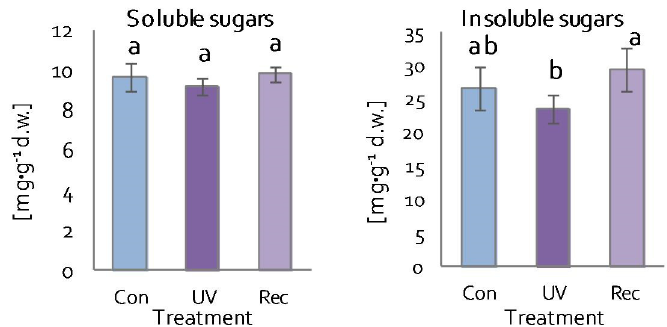
Figure 5. Soluble and insoluble sugar contents in D. muscipula leaves under UV-A treatment; Con— control plants; UV—UV plants; Rec—recovery plants; different letters—statistically significant differences at p ≤ 0.05; n = 5.